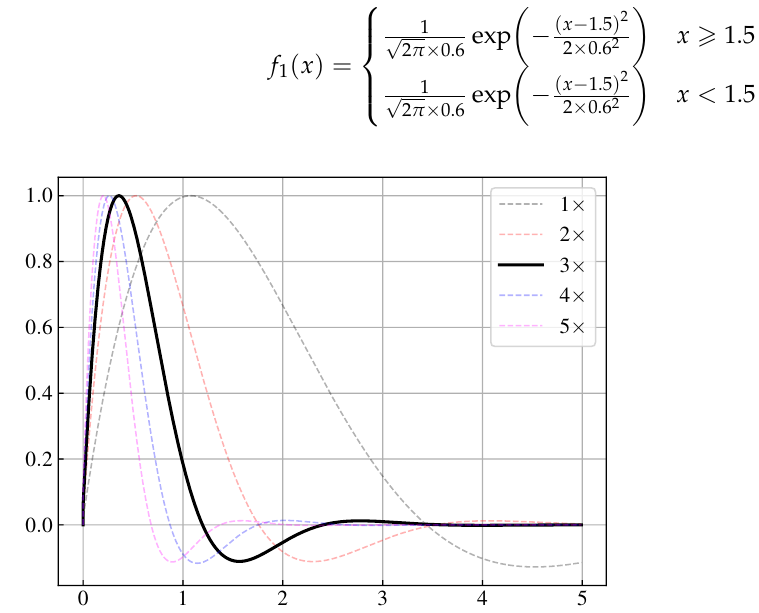
Figure 3. Generating Trajectories under different times of slope